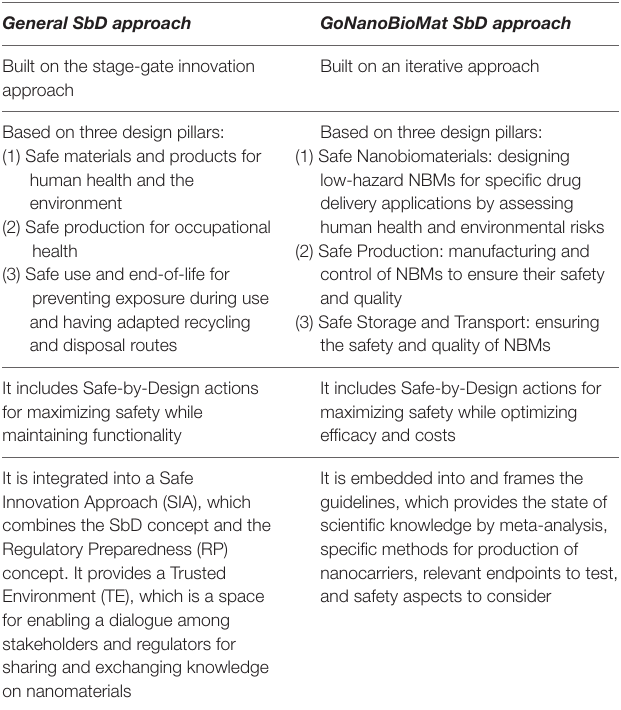
TABLE 1 | Comparison of the general SbD approach developed by NANoREG, NanoReg2, and the ProSafe initiative with the GoNanoBioMat SbD approach. Comparison of the general and GoNanoBioMat SbD